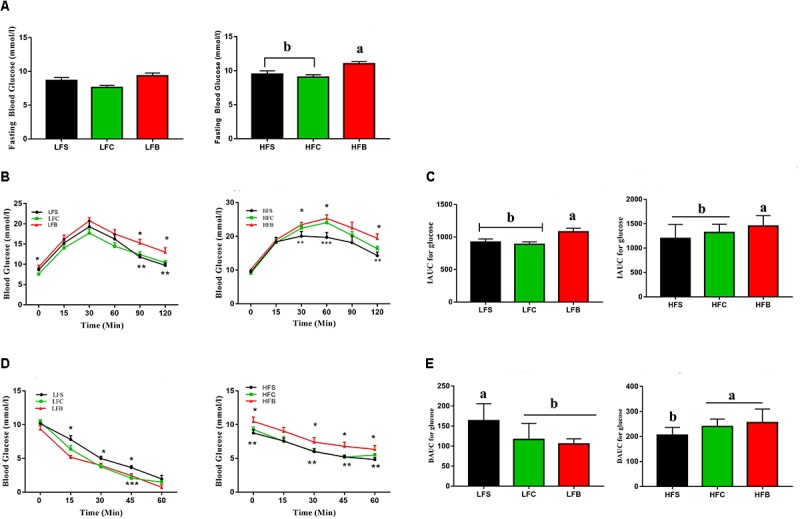
Glucose and insulin tolerance. (A) Feed-deprived (6 h) blood glucose levels before starting the oral glucose tolerance test (n = 10/group). (B) Glucose response curve after administration of 3-mg glucose/g lean mass by gavage (n = 10/group). (C) Incremental area under the curve (IAUC) (n = 10/group). (D) Glucose response curve after administration of 0.75 units insulin/kg lean mass, n = 10/per group except in LF where n = 8 at time point 0 and 15 min and n = 6, 7, and 8, respectively, for beef, soy and casein protein at 30 min (four mice were treated with glucose due to low blood glucose levels and data points after treatment were therefore not included). (E) Decremental area under the curve (DAUC), n = 10 for the high fat groups and n = 6 in low fat groups. The data represent group means ± SEM and different alphabetic letters and numerical asterisk (∗) denote statistical significance (P < 0.05).